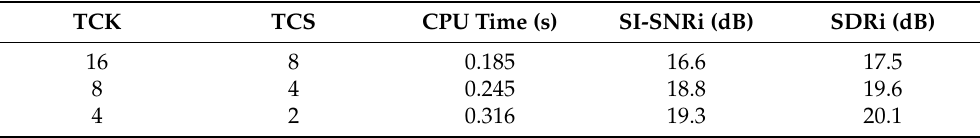
Table 5. Time spent and separation performance of our network with different convolutional kernel sizes and convolutional strides in DPTTNet